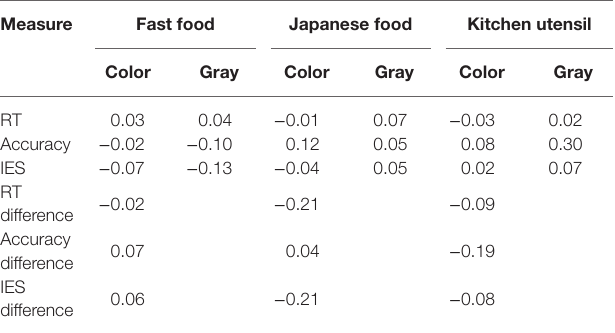
TABLE 1 | Pearson’s correlation coefficients between subjective hunger level and visual search performance measures.